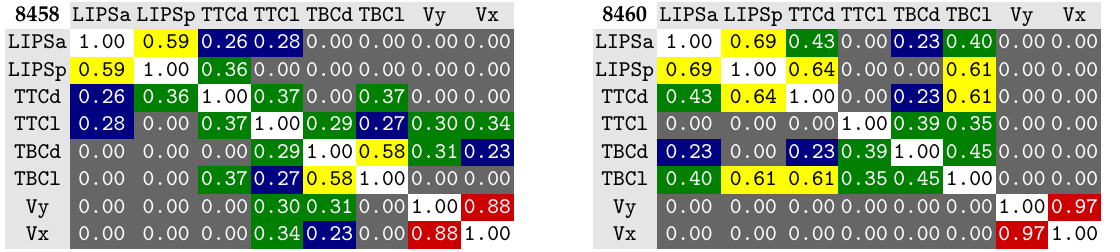
Figure 7. Correlation matrices for previous results [25] considering Articulatory Phonology aligned tract variables for two of the speakers also considered in this work (8458 and 8460). In this previous work, we considered less data samples per speaker and represented the velum by the x and y coordinates of a landmark positioned at its back. Please refer to Figure 6 for the corresponding matrices obtained in the current work. Tract variables for 1D correlation (previous work): LIPSa : lip aperture; LIPSp : lip protrusion; TTCd : tongue tip constriction distance; TTCl : tongue tip constriction location; TBCd : tongue body constriction distance; TBCl : tongue body constriction location; Vx :